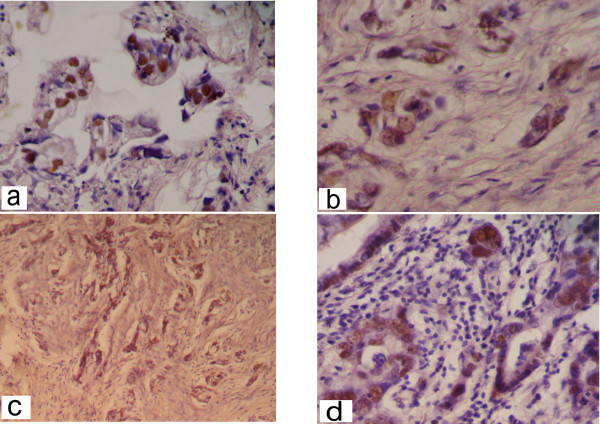
Photomicrograph showing all p53 staining. (1a) nuclear p53 positivity in well differentiated adenocarcinoma; (1b and c) in invasive high grade adenocarcinoma; (1d) strong positivity in moderately differentiated adenocarcinoma